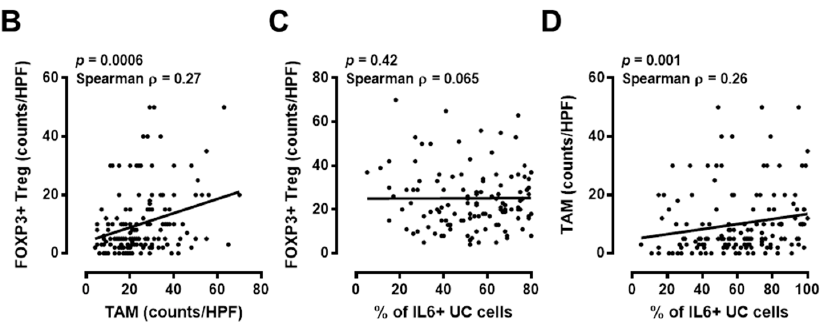
Figure 1. Immunohistochemical quantification of regulatory T cells, tumor-associated macrophages, and IL6-positive urothelial carcinoma cells. ( A ) Representative expression status of FOXP3, CD204, and IL6 in human bladder cancer tissues. Images were captured at 100× (FOXP3) or 200× (CD204 and IL6) magnification. Black arrowheads in the FOXP3 and CD204 images indicate positive-stained immune cells that exist in the stroma near the cancer cells or filtrate to the tumors. Scale bars, 200 μ m. The interrelationship between ( B ) the Treg counts and TAM counts, ( C ) the Treg counts and the percentage of IL6 + cancer cells, and ( D ) the TAM counts and the percentage of IL6+ cancer cells were examined using Spearman’s correlation. HPF, high power field; Treg, regulatory T cell; TAM, tumor-associated macrophage; UC, urothelial